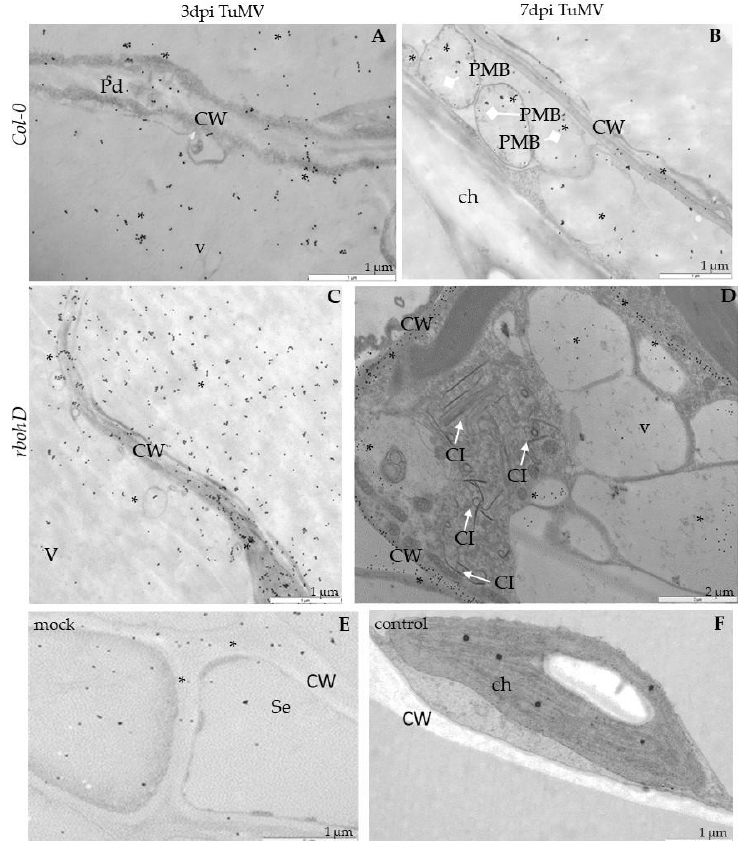
Figure 9. Localization of PR1 in Col-0 and rbohD leaf tissues 3 ( A , C ) and 7 days ( B , D ) after TuMV inoculation examined by immunogold electron microscopy. Control comprises Col-0 mock-inoculated leaf tissues ( E ) and leaf tissues without primary antibodies ( F ). ( A ) PR1 (*) in cell wall (CW), plasmodesmata (Pd) and vacuole (v) in Col-0 mesophyll 3 days after TuMV inoculation. ( B ) PR1 presence (*) in cell wall (CW), paramular bodies (PMBs; diamond head arrow) in apoplast area of palisade mesophyll Col-0 plants 7 days after TuMV inoculation. ( C ) PR1 localization (*) in cell wall (CW) and vacuoles (vs) in rbohD 3 days after TuMV inoculation. ( D ) PR1 deposition (*) along cell wall (CW) and in vacuoles (vs) in rbohD spongy mesophyll cell with virus cytoplasmic inclusions (CI with arrow). ( E ) PR1 (*) in cell wall (CW) and vacuole (v) in di ff erent type of phloem cells from mock-inoculated Col-0 plants. Se—sieve element. ( F ) Mesophyll from mock-inoculated Col-0 control plants without PR1 epitopes when primary antibodies were replaced by pre-immune serum. ch—chloroplast; CW—cell